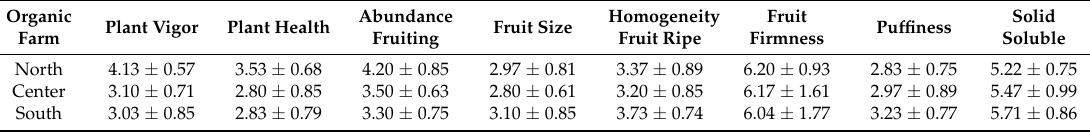
Table 7. Mean values (range from one to four except for fruit firmness, which was expressed as kg cm − 2 and solid soluble as ◦ Brix) of plant parameters (mean ± standard